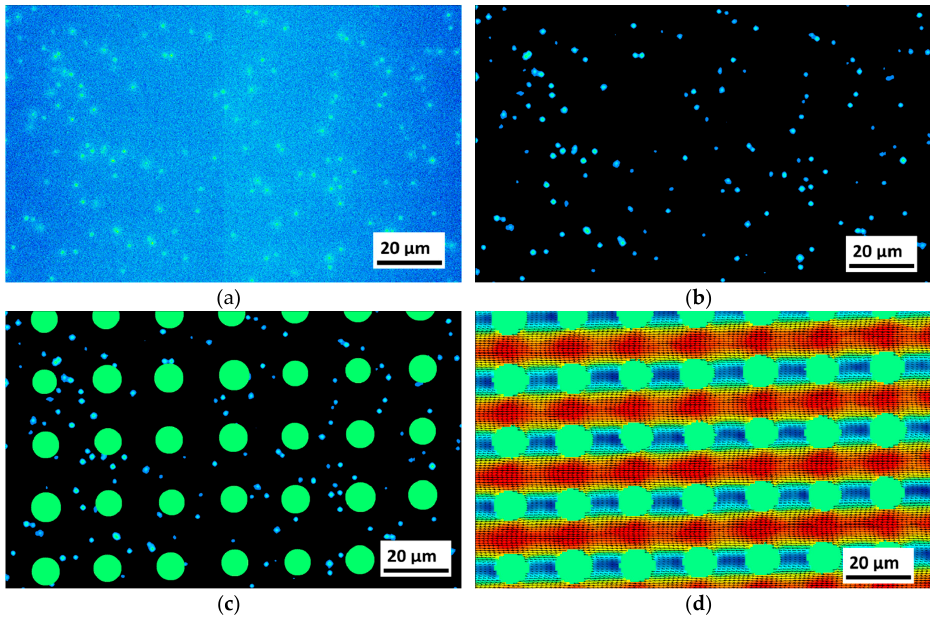
Figure 5. Illustration of the image processing steps (example image taken for Re = 7.62): ( a ) The raw camera fluorescence image. In the center of the image, the brightness level slightly but abruptly changes, which is an artifact induced by the camera technology and does not cause problems with the image correlation procedures. ( b ) Image after post processing. ( c ) Image with post areas masked. ( d ) The final µPIV result of the measurement set consisting of 1500 frames. All Images show precisely the same area.